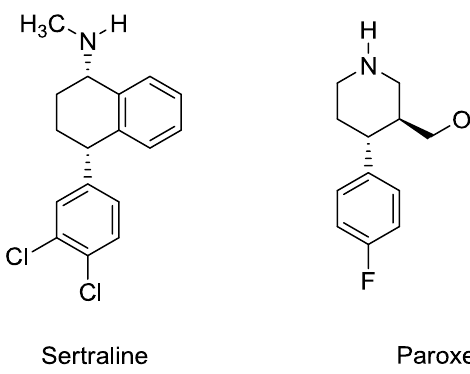
Figure 1. The structures of sertraline, paroxetine, and chlorpromazine.